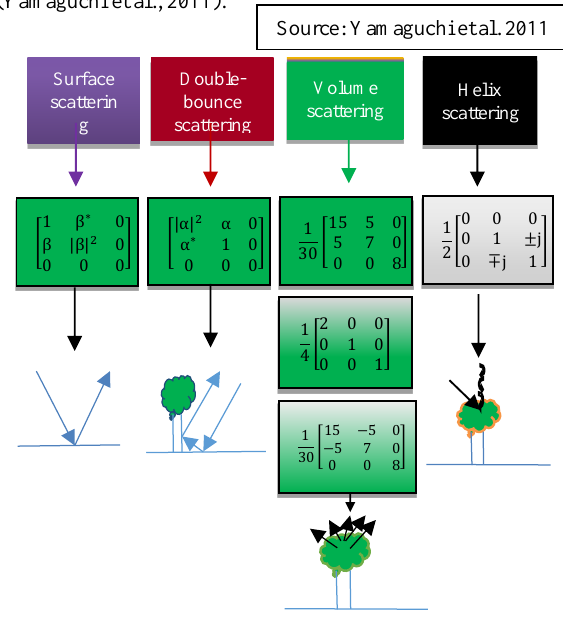
Figure 2: Yamaguchi decomposition model Field Survey (Barkot